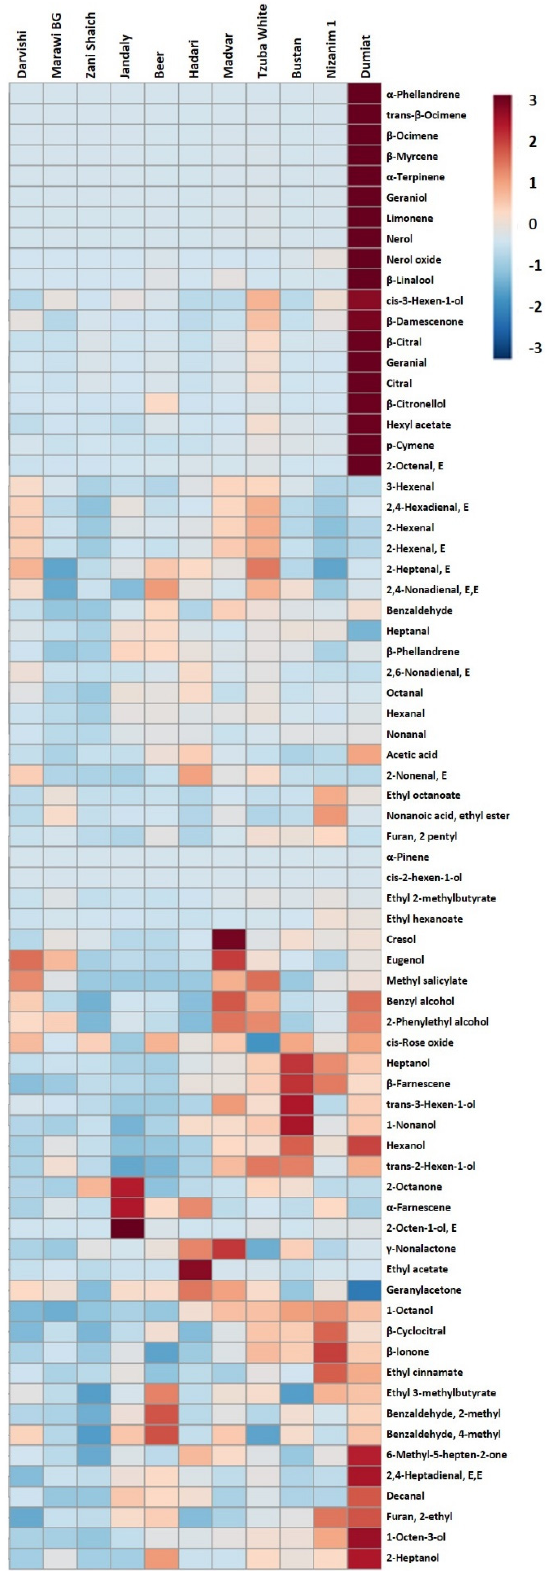
Figure 6. Mean volatile composition of white indigenous cultivars ( µ g/kg berries; n = 3 replicates per variety). For this visualization, mean concentrations were normalized across the observed concentra- tion range, as shown in the figure key. For numerical data, see Supplementary Materials Table